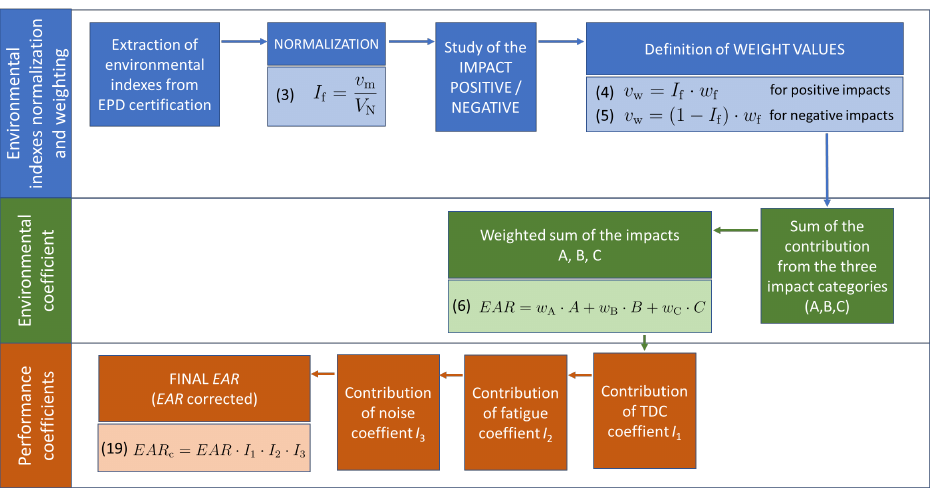
Figure 1. EAR and EAR c calculation flow chart.